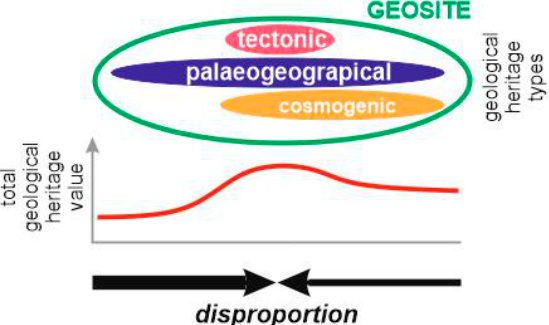
Figure 3. Conceptual representation of the idea of big and complex geosite disproportion. Arrows indicate increase in geological heritage concentration (the wider the arrow, the bigger the increase). The geological heritage types are chosen provisionally just to give an example, and it is supposed that all types are valued equally in this example.